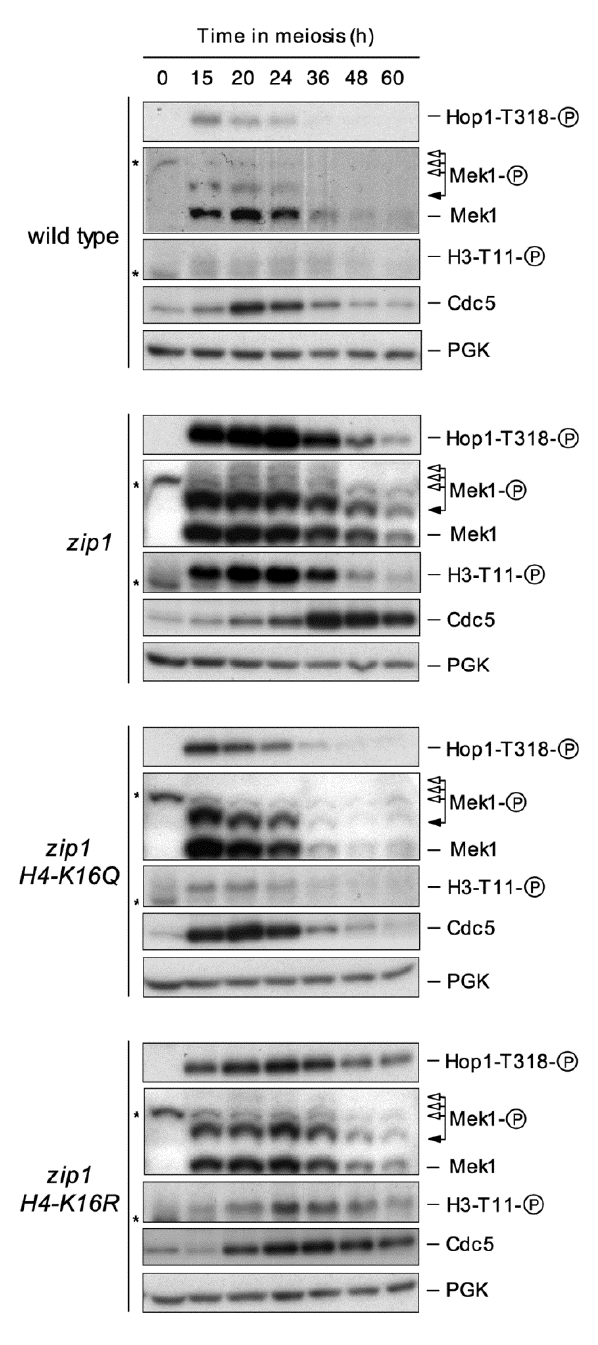
FIGURE 3: H4K16 acetylation is necessary for normal Mek1 and Hop1 phosphorylation. Western blot analysis of Mek1 and Hop1 activation in wild type (DP421), zip1 (DP422), zip1 H4-K16Q (DP1001) and zip1 H4-K16R (DP995) strains throughout meiosis. Black arrows point the Mec1/Tel1-dependent phosphorylated form of Mek1, whereas white arrows mark the bands resulting from Mek1 autophosphorylation [21]. Asterisks mark non-specific bands. H3T11 phosphorylation and Cdc5 inhibition were used as additional molecular markers for checkpoint activation. PGK was used as a loading